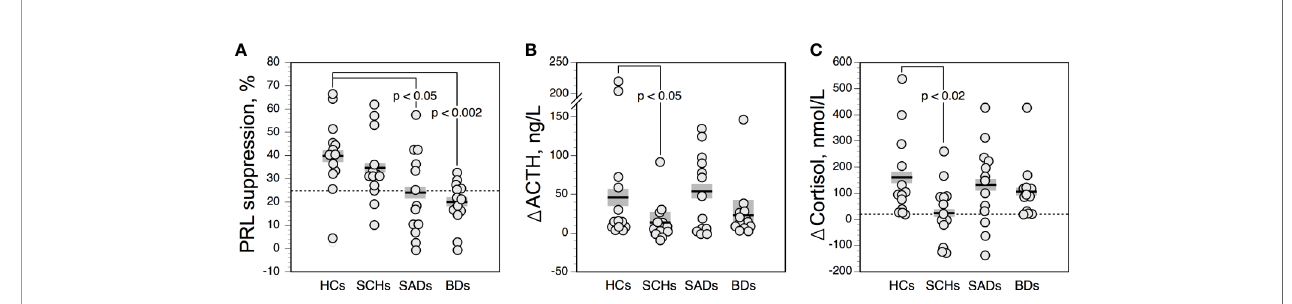
FIGURE 1 | Prolactin suppression (A) , and maximum increment in serum adrenocorticotropic hormone (ACTH) (B) , and cortisol (C) above baseline after 0.75 mg SC of apomorphine in controls and patients. The solid horizontal lines indicate the group mean; the shaded areas represent ± SEM. HCs, healthy control subjects; SCHs, patients with paranoid schizophrenia; SADs, patients with schizoaffective disorder; BDs, patients with bipolar depression.